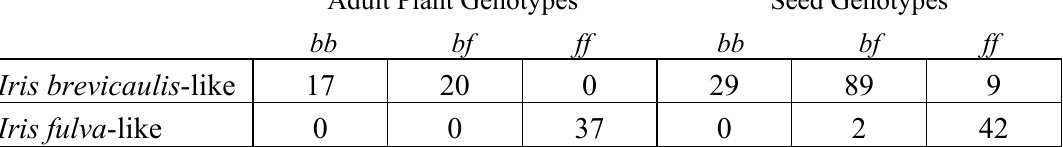
Table 1. The frequency of homozygous I. brevicaulis (“bb”), heterozygous (“bf”) and homozygous I. fulva (“ff”) genotypes among adult plants and seeds from an I. fulva x I. brevicaulis natural hybrid zone